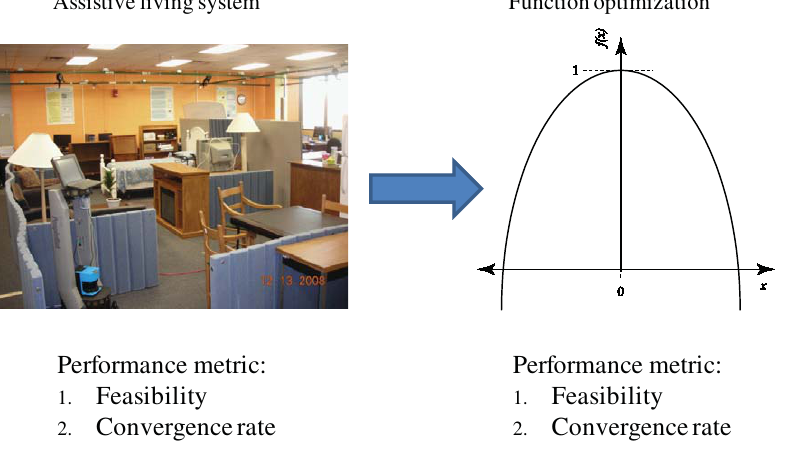
Fig. 3. Mapping between problem